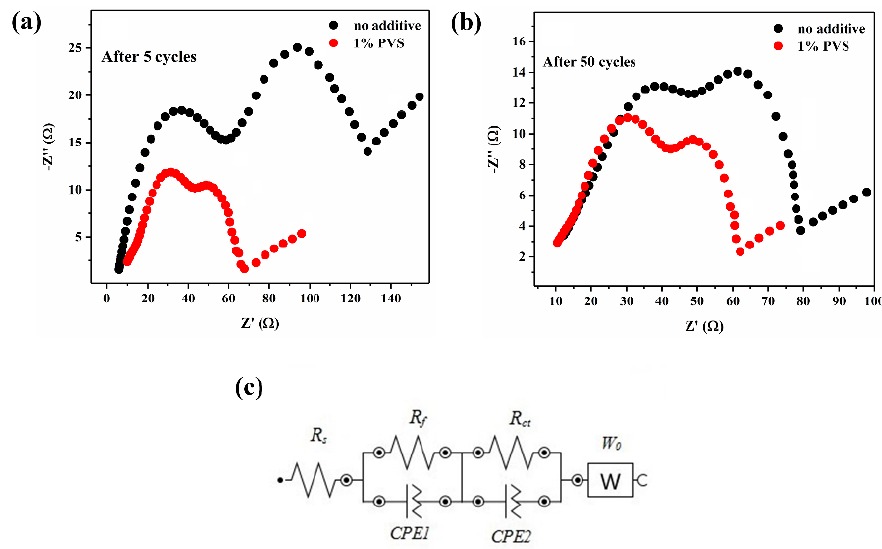
Figure 5. The Nyquist curves of Li/graphite half-cells without and with 1% PVS after ( a ) 5 cycles of 0.5 C as the formation, and ( b ) after 50 cycles of 1 C. ( c ) The equivalent circuit adopted for simulating the experimental results.